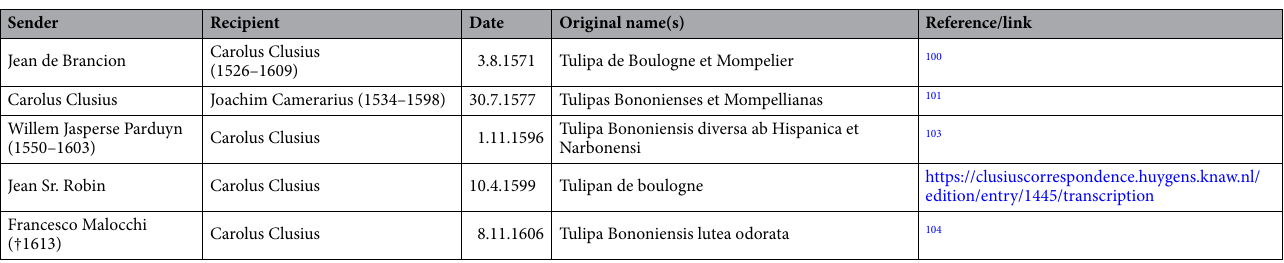
Table 3. Tulipa sylvestris in mail correspondence of sixteenth century botanists and